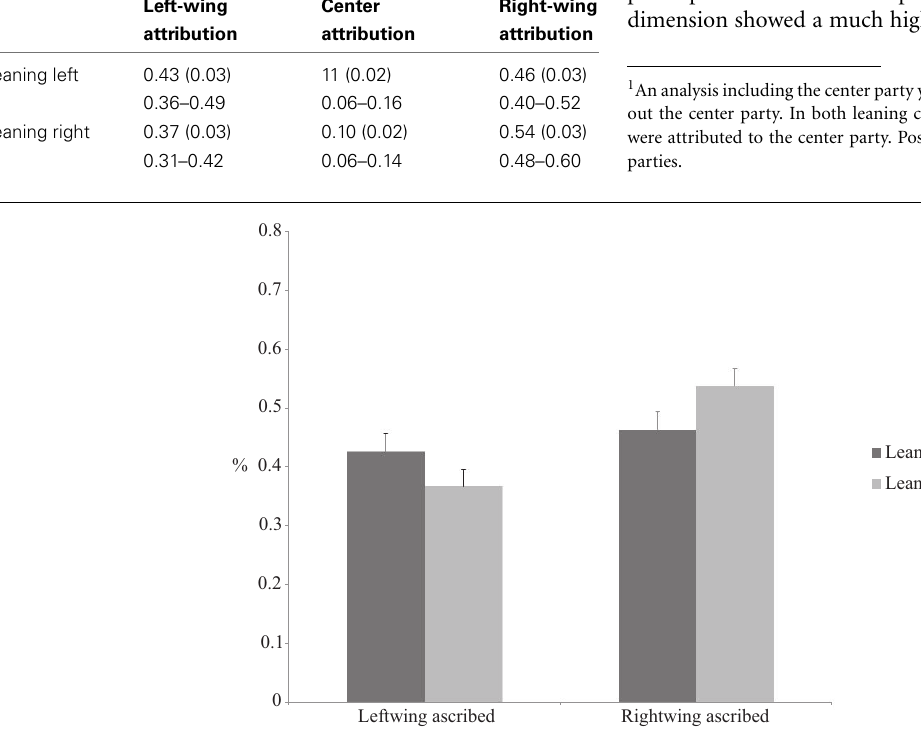
FIGURE 1 | Number of ascribed statements to left- and right-wing parties by leaning